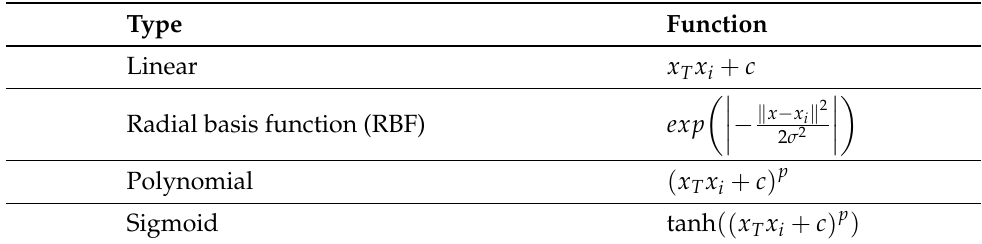
Table 1. Kernel functions for the proposed